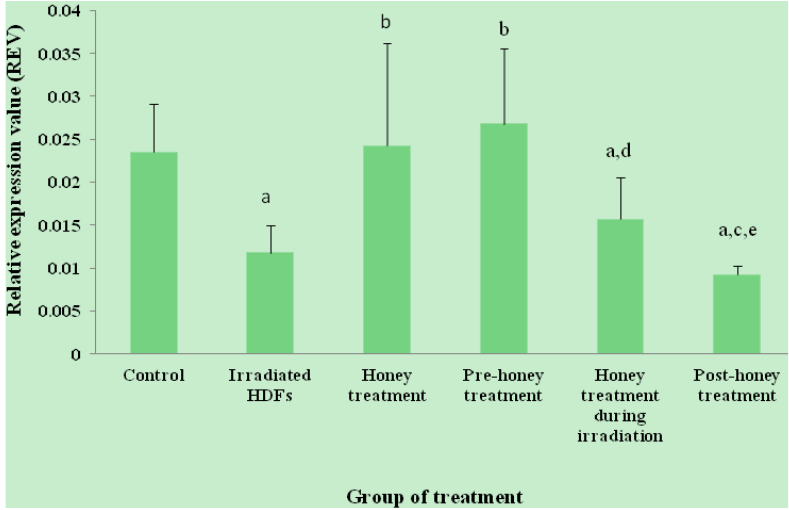
Figure 3. Expression of CAT gene in different HDFs treatment groups. HDFs were pre-, during- and post-treated with 6 mg/mL of Gelam honey for 24 h and exposed to 1 Gy of gamma rays. Results are expressed as means + S.D (n = 6). a Denotes p < 0.05 compared to untreated control, b p < 0.05 compared to irradiated HDFs, c p < 0.05 compared honey treated-HDFs, d p <0.05 compared to pre-honey treated-HDFs, e p < 0.05 compared to honey treated-HDFs during irradiation.